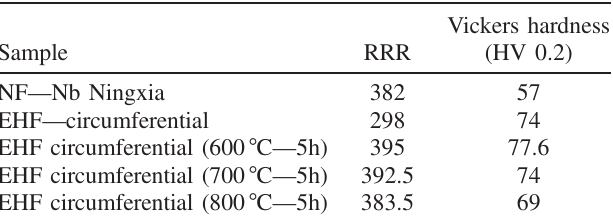
TABLE II. Values of RRR and Vickers Hardness for specimens of niobium extracted from circumferential direction of EHF